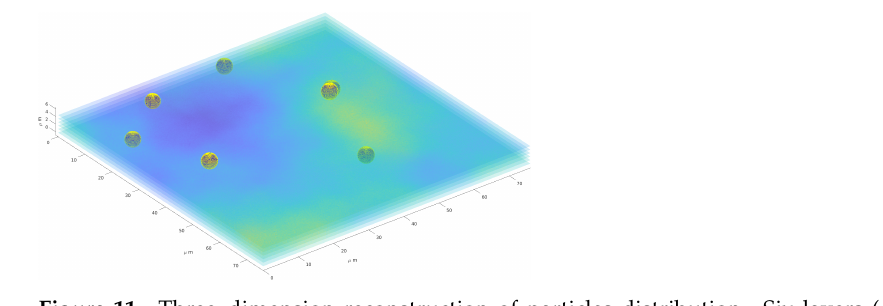
Figure 11. Three–dimension reconstruction of particles distribution. Six layers (out of 22) are superimposed to the sphere representing the particles.